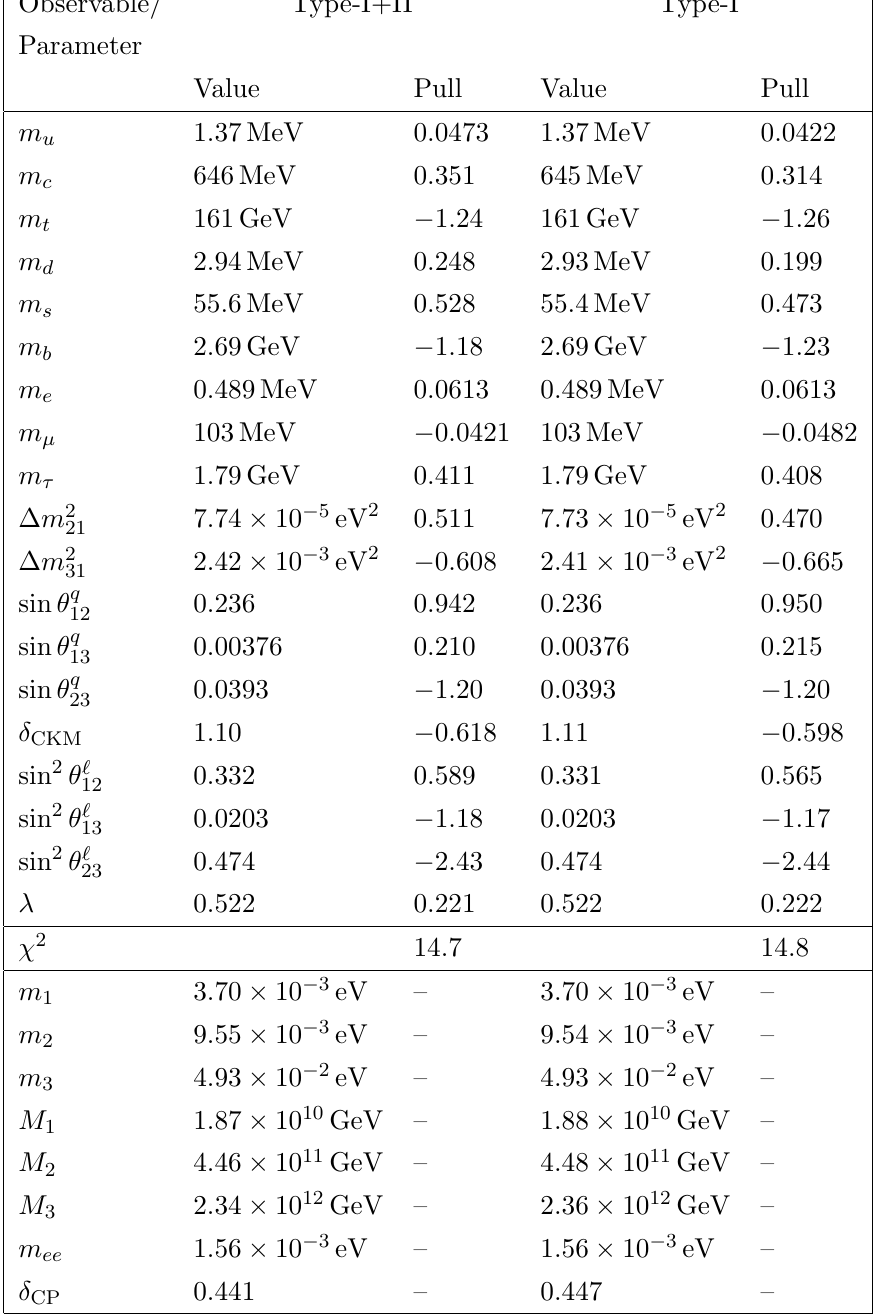
Table 3 . Predicted values of the observables that are included in the (cid:12)ts together with the asso- ciated pulls for the two cases of type-I+II seesaw and pure type-I seesaw, respectively, and normal neutrino mass ordering. Shown are also predicted values for some of the unknown parameters of the neutrino sector, which are not included in the (cid:12)ts, namely the small neutrino masses m 1 , m 2 , and m 3 , the large right-handed neutrino masses M 1 , M 2 , and M 3 , the e(cid:11)ective neutrinoless double beta decay mass m ee , and the leptonic CP-violating phase (cid:14) CP .